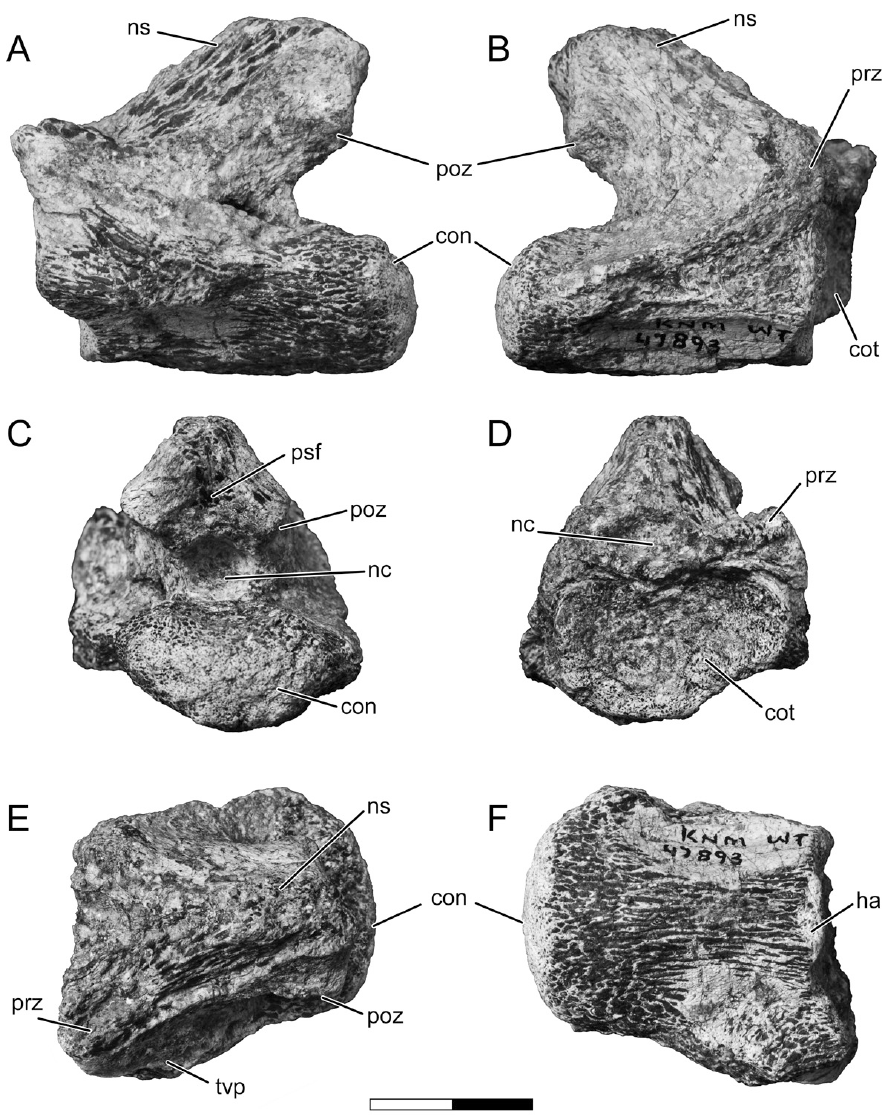
Fig. 2–Caudalcervicalvertebra(KNM-WT47893)ofAzhdarchidaeindet. inleftlateral (A) ,rightlateral (B) , caudal (C) , cranial (D) , dorsal (E) , and ventral (F) views. Abbreviations: con , condyle; cot , cotyle; ha , hypapophysis; nc , neural canal; ns , neural spine; poz , postzygapophysis; prz , prezygapophysis; psf , postspinal fossa, tvp , transverse process. Scale bar equals 2.0 cm in A – E